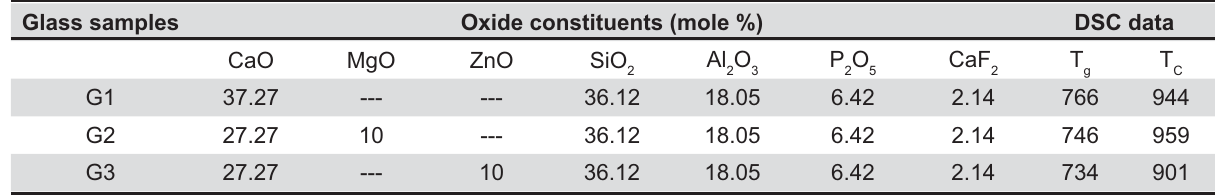
Table 1- Glass composition and differential scanning calorimeter (DSC) data of the experimental glasses for glass ionomer